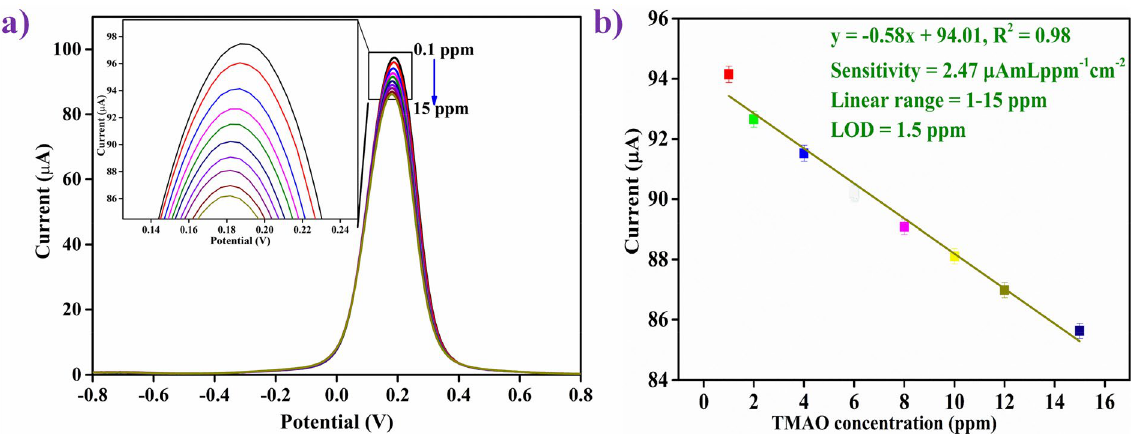
Figure 3. ( a ) DPV response studies of MIP/ITO electrode as a function of TMAO concentration (0.1– 15 ppm mL −1 ) in pH 7.4 of PBS (0.2 M, 0.9% NaCl) containing [Fe(CN) 6 ] 3-/4- ; (inset) magnified view of peak currents ( b ) calibration curve between the magnitude of peakcurrent and concentration of TMAO (ppm mL −1